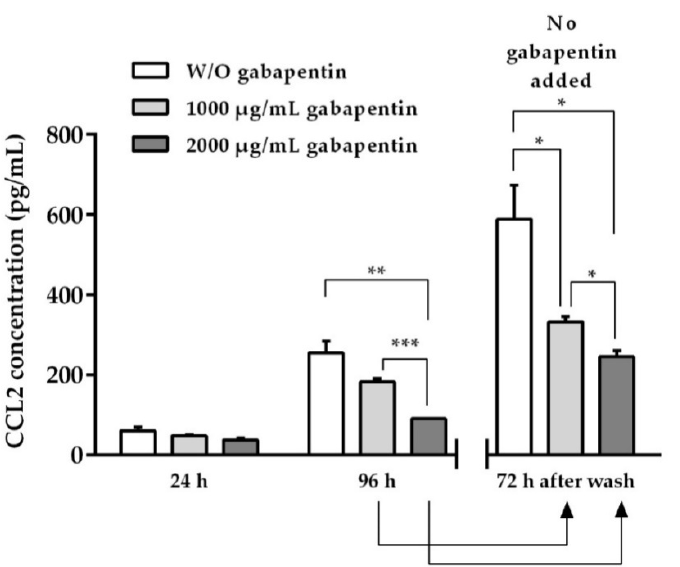
Figure 6. CCL2 concentration: Effect of gabapentin on the CCL2 secretion in B16–BL6/Zs green murine melanoma cells. Cultures were incubated with gabapentin (1000 or 2000 μ g/mL) for 24 and 96 h, and 72 h after gabapentin washout (no additional gabapentin added). ELISA analyzed supernatants obtained from 3 independent assays ( n = 3, each by triplicate), which were used to determine the chemokine concentration. Each column represents the mean ± SEM. * p ≤ 0.04, ** p ≤ 0.005, *** p ≤ 0.0005.